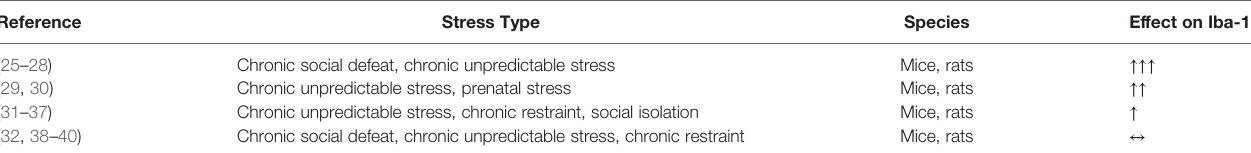
TABLE 1 | Effect of psychosocial stress on microglial activity in prefrontal cortex.